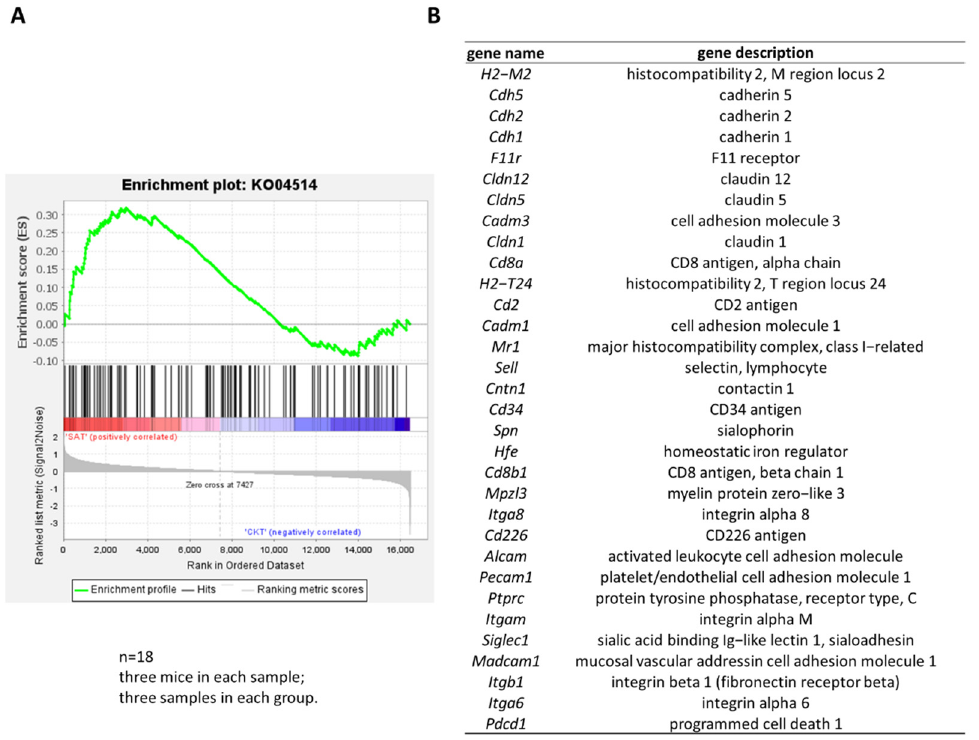
Figure 5. GSEA of B220, CD40, and CD68 related gene sets. ( A ) Gene set enrichment analysis of ko04514; ( B ) genes contribute to the leading-edge subset within ko04514 gene set.